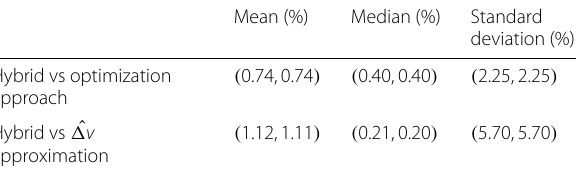
Standard deviation (%)